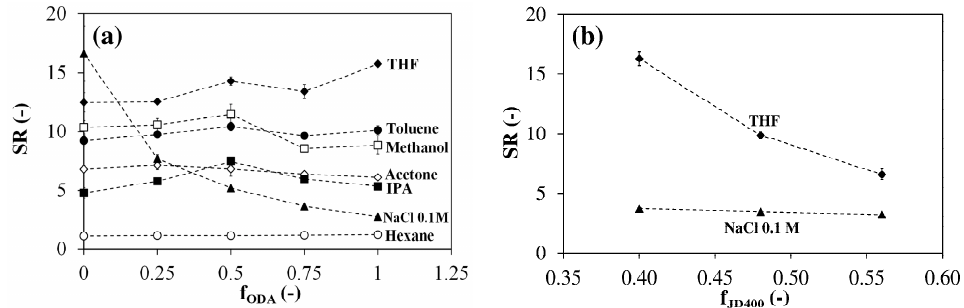
Figure 8. ( a ) Room temperature swelling ratio in various solvents as a function of f ODA (q = 0.80; f JD400 = 0.40). ( b ) Effect of f JD400 on the room temperature swelling ratio in THF and in NaCl 0.1 M (q = 0.80; f ODA = 0.75). Each datum represents the average of four